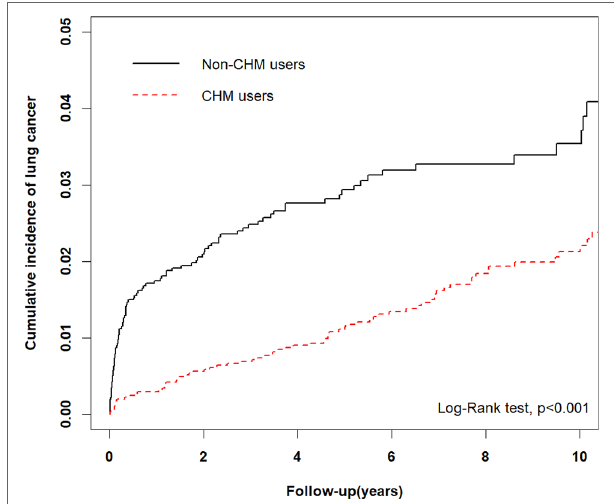
FIGURE 2 | Comparison of Kaplan-Meier estimates of the 10-year cumulative incidence of lung cancer in COPD patients with and without CHM usage (Log-rank test, p <